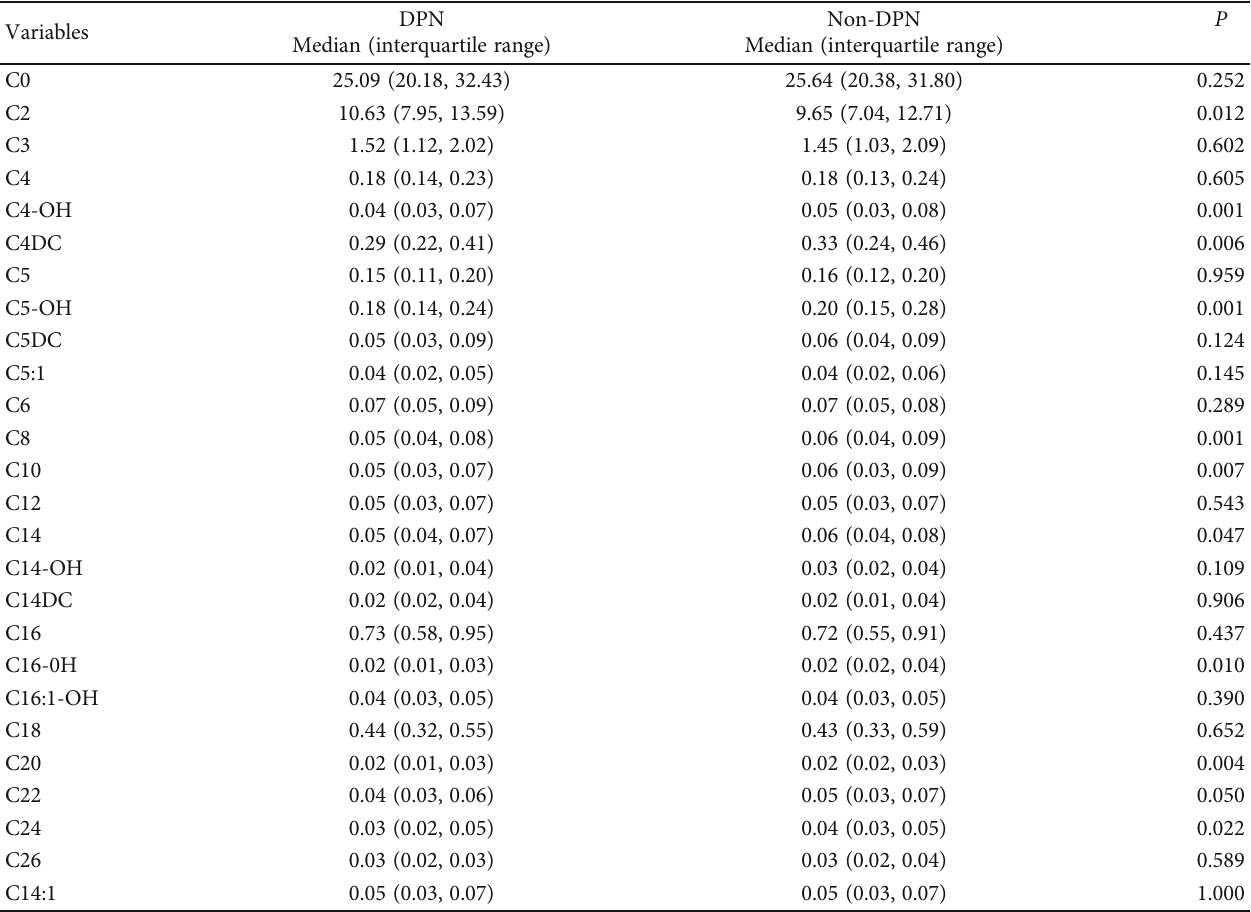
Table 2: Acylcarnitine pro fi le in T2DM